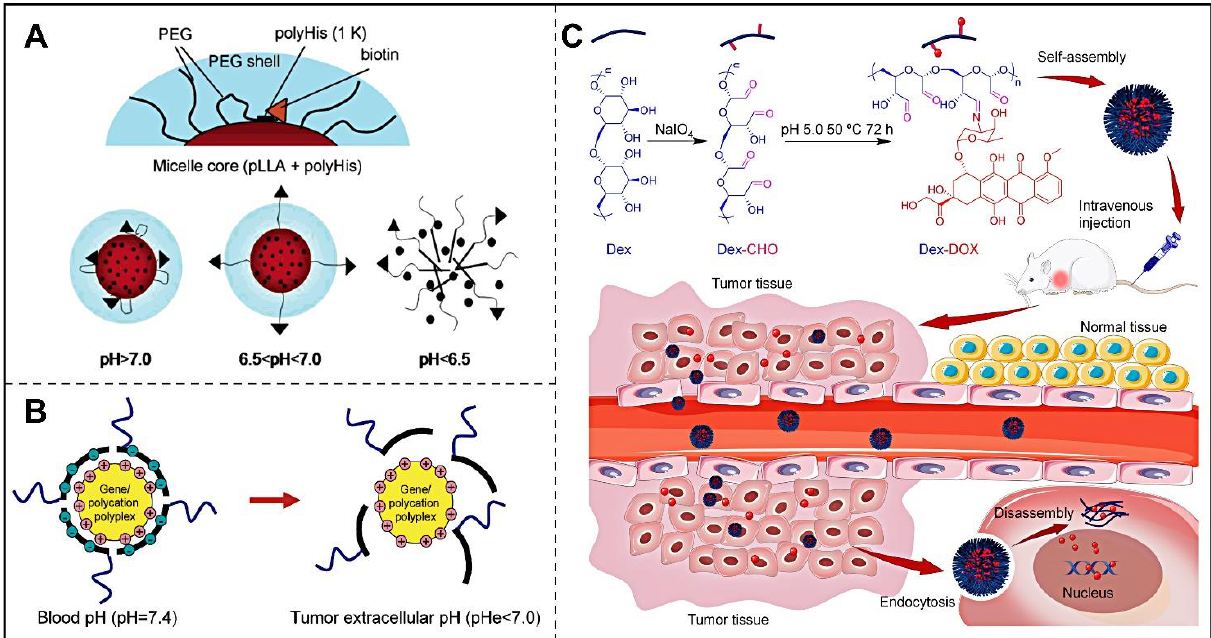
Figure 1. Design and responsive mechanism of pH-triggered srNPs. ( A ) Schematic depicting the pH-induced change of the micelle based on polyHis. Reproduced with permission [45]. Copyright 2005, American Chemical Society. ( B ) Illustration of the pH-responsive shielding/deshielding of polymeric nanoparticles containing sulfonamide at different pH. Reproduced with permission [51]. Copyright 2006, American Chemical Society. ( C ) Self-assembly and in vivo pH-triggered disassembly of Dex-DOX connected by the imine bond. Reproduced with permission [70]. Copyright 2017, Elsevier.